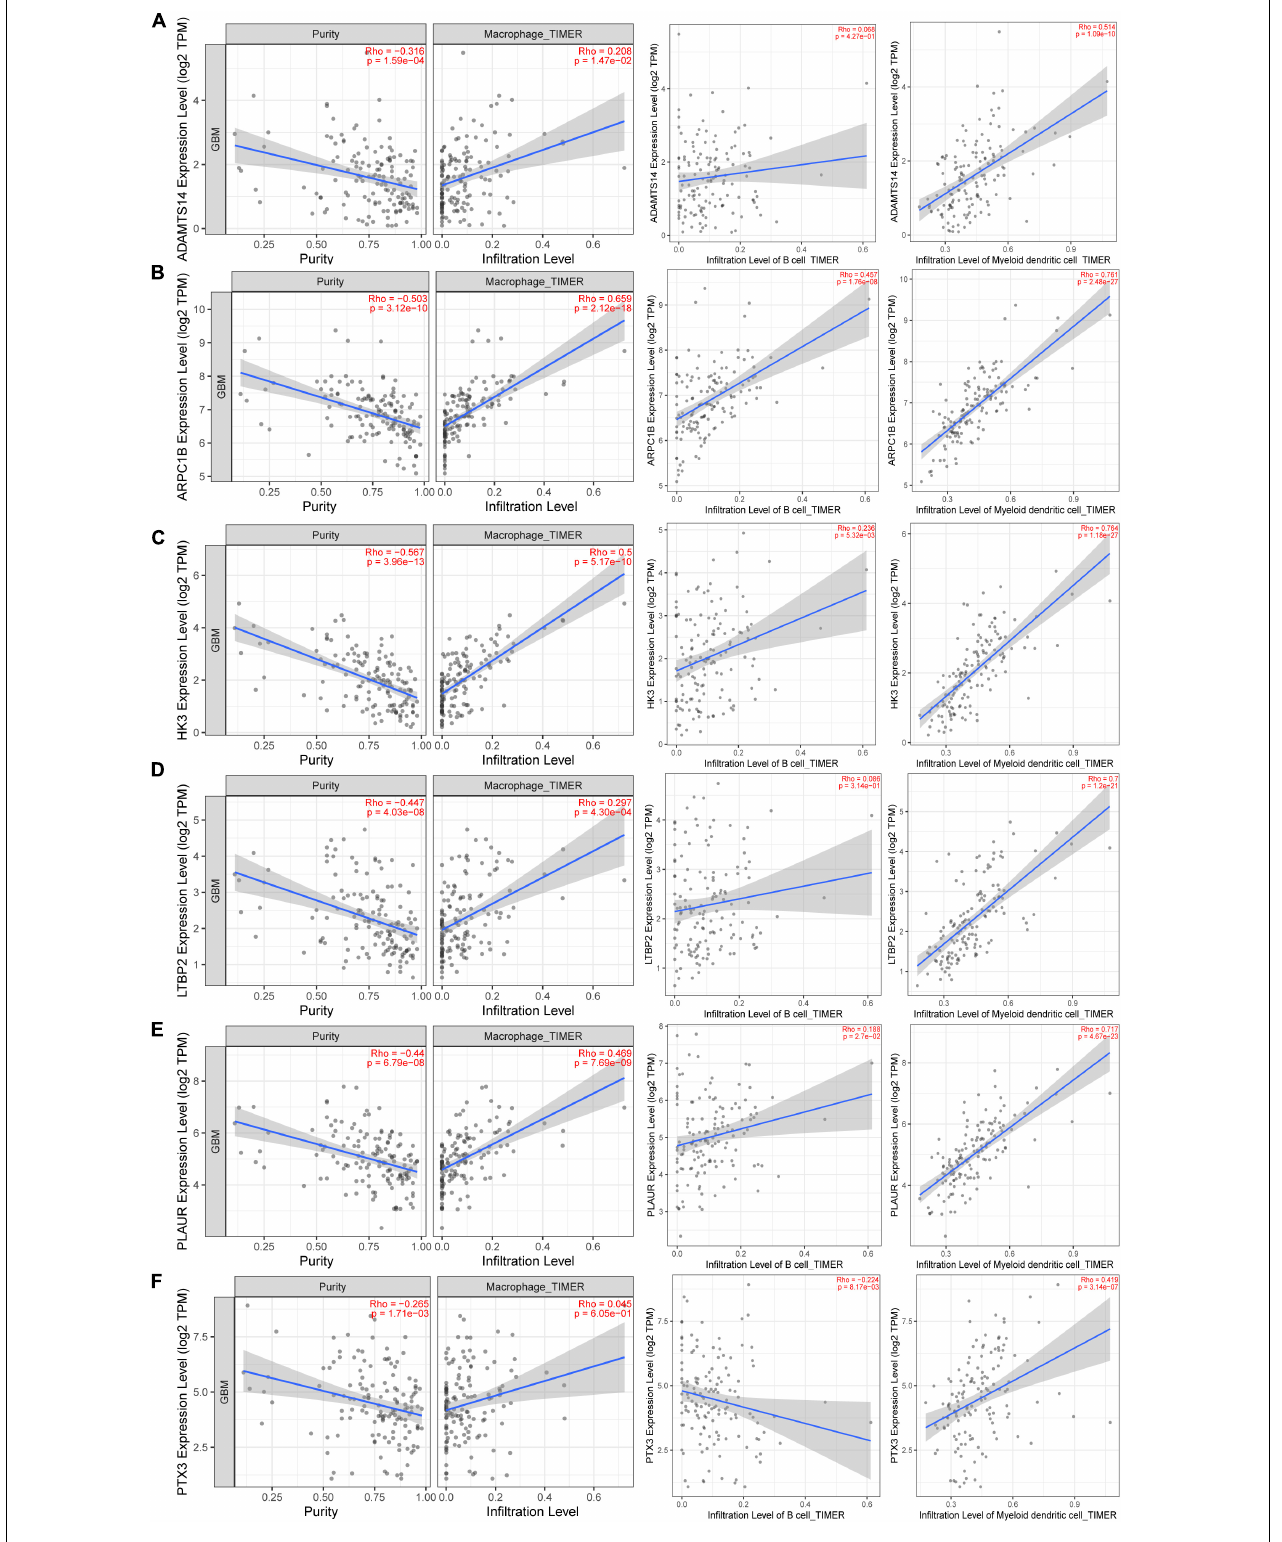
FIGURE 3 | The association between six potential mRNA antigens and antigen-presenting immune cells (APCs). According to the Tumor Immune Estimation Resource (TIMER) 2.0 database, the correlation between tumor purity, the infiltration level of APCs (Macrophages, B cells, and myeloid dendritic cells), and the expression level (Log2 TPM) of (A) ADAMTS14, (B) ARPC1B, (C) HK3, (D) LTBP2, (E) PLAUR, and (F) PTX3. APCs, antigen-presenting cells.